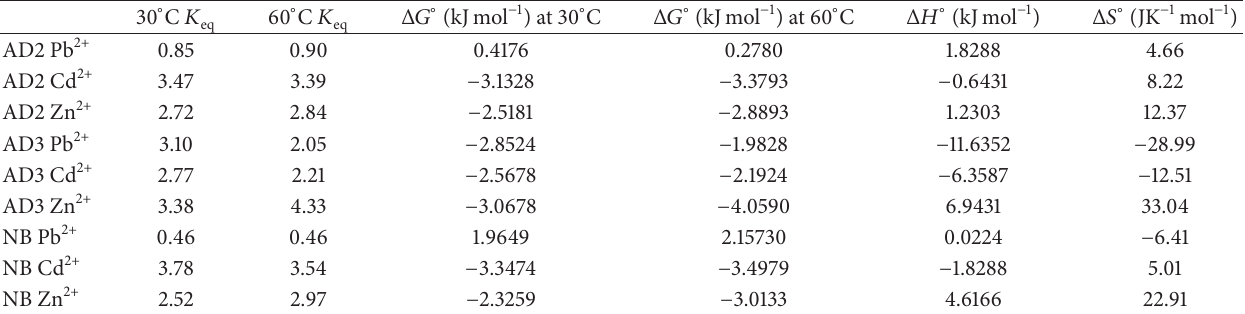
Table 4: Thermodynamic data for adsorption on samples AD2, AD3, and